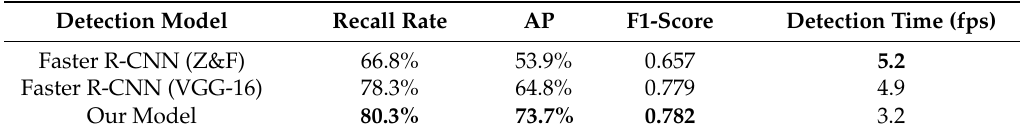
Table 4. Comparison results of various detection models on Munich Vehicle dataset.